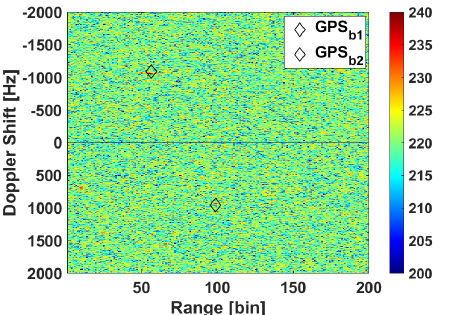
Figure 15. RD map of CPI 59 for validation of the designed reflectarray in scenario